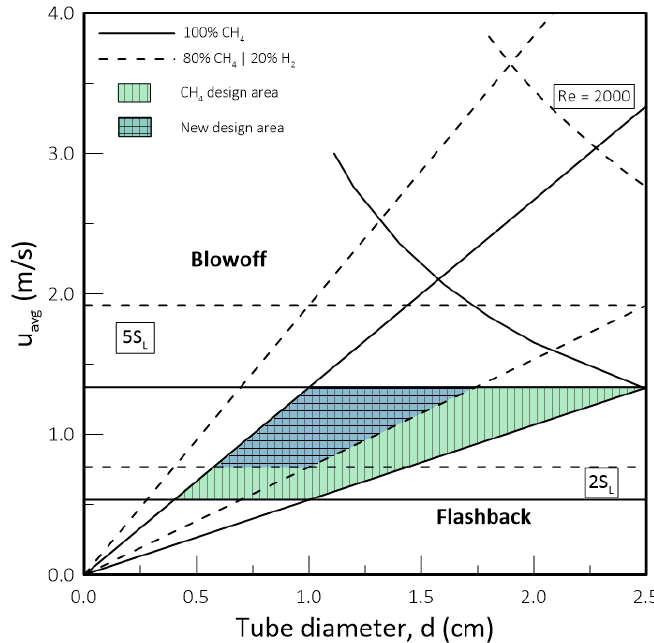
Figure 8. Stability and operation limits of Bunsen-based combustion devices fuelled by the blends described in Table 2. Horizontal lines delineate the upper (5 S L ) and lower (2 S L ) boundaries for u avg . Lines starting from the origin of the plot correspond to the blowoff and flashback limits. Limitations for laminar flow are delineated by the curves on the top right-hand side of the